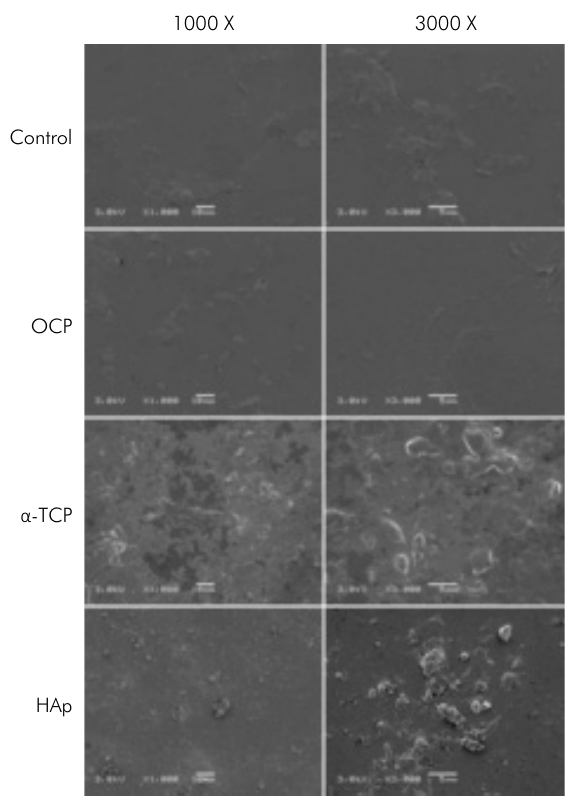
Figure 2. SEM images (1,000× and 3,000×) of samples after immersion in saliva for 28 days. Mineral deposits are observed for the HAp and α -TCP groups and are better observed at 3,000× magnification. OCP did not promote deposition in the specimens.